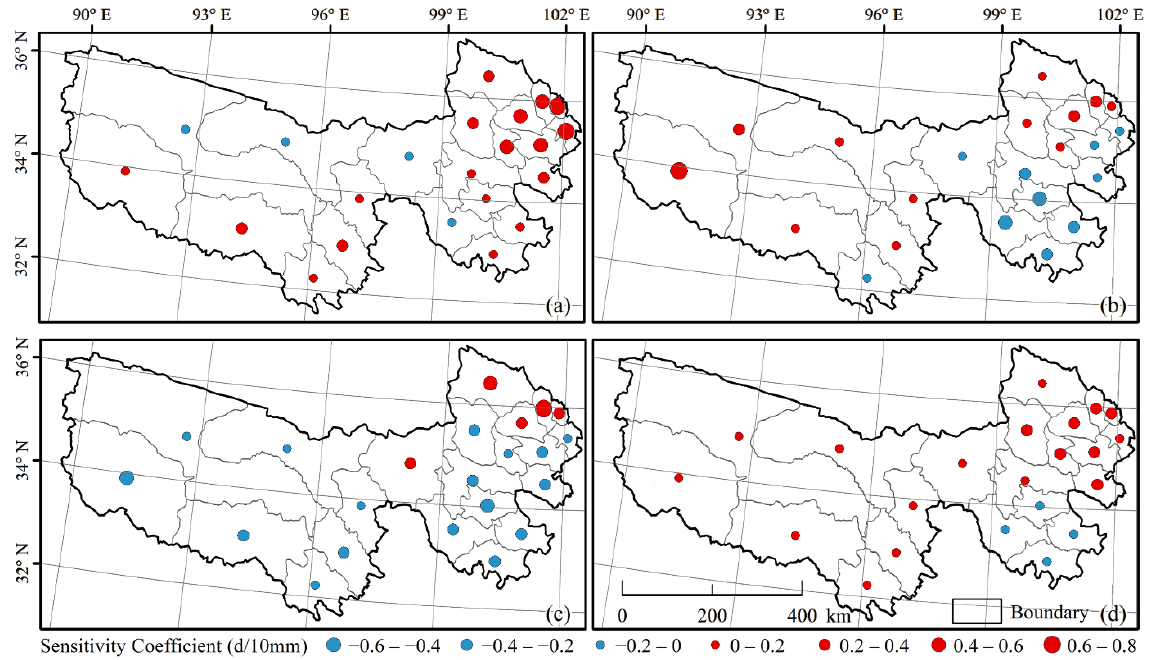
Figure 17. Spatial distribution of the sensitivity coefficients between the EOS of the vegetation and precipitation in August ( a ), September ( b ), October ( c ) and August – October ( d ) in the Three-River headwaters region.